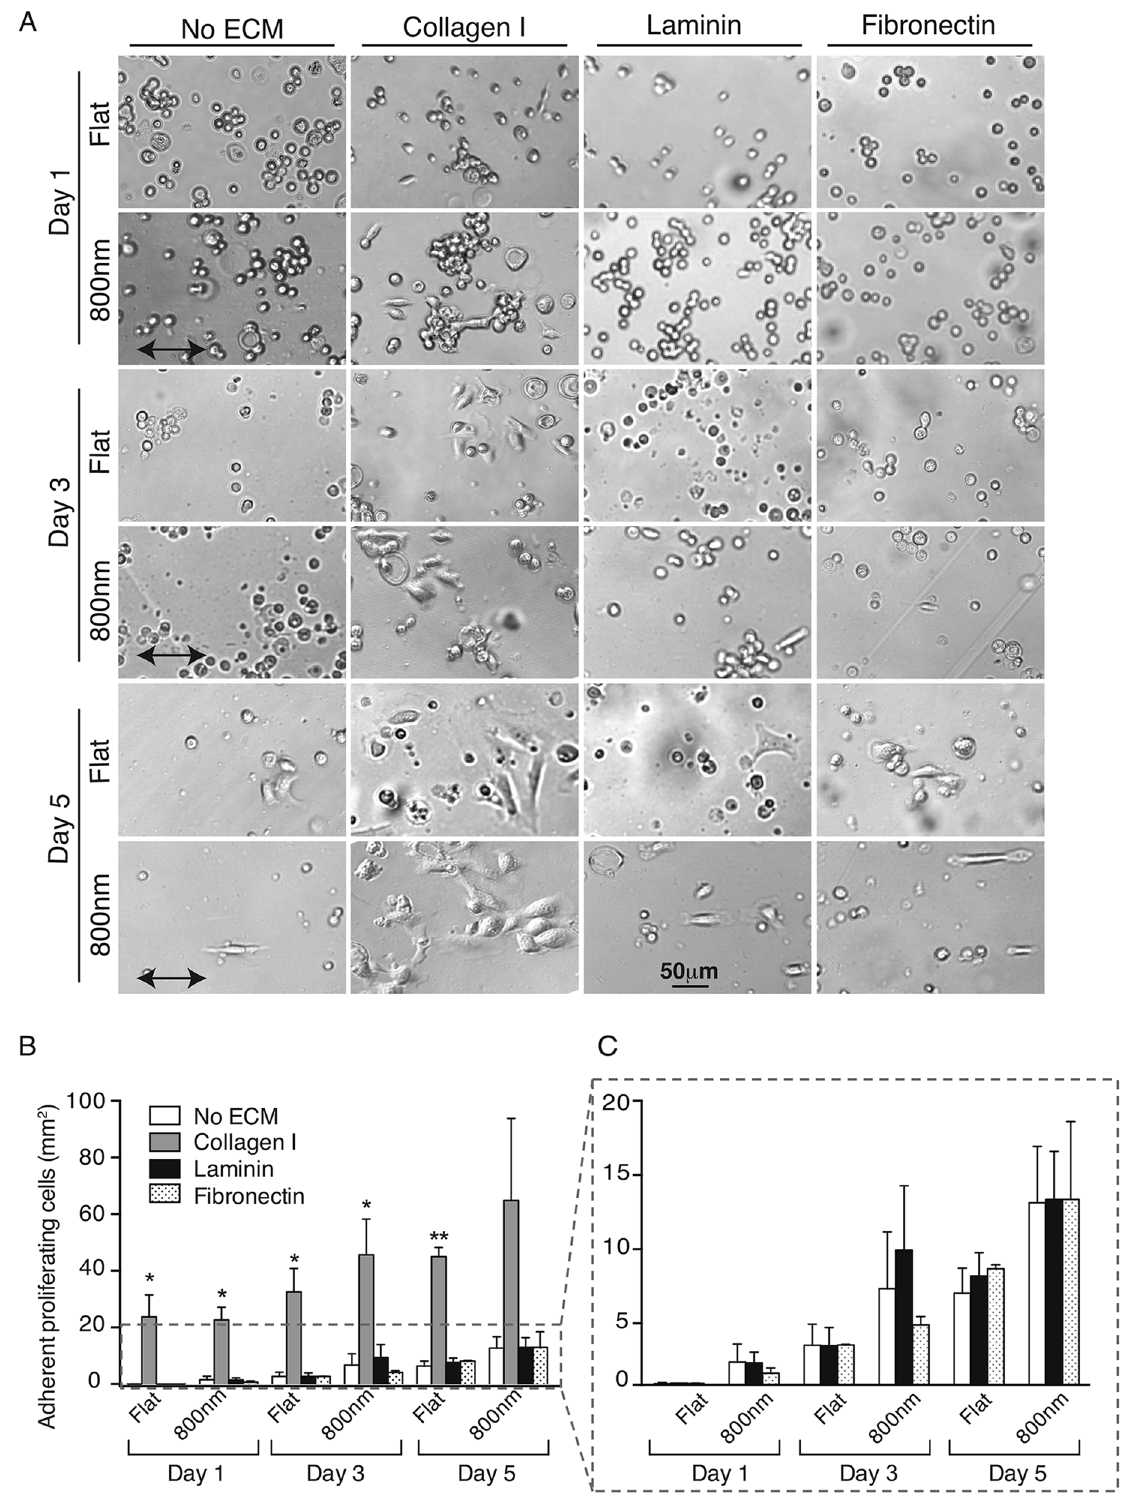
Figure 2. Collagen I coating of silk films enhanced cellular spreading and growth. MCEC were seeded on uncoated or collagen I, laminin, fibronectin or Poly-d-Lysine coated flat or 800 nm patterned silk films. ( A ) Representative phase-contrast images showing cellular shape and spreading. Higher cell number was observed on collagen I coated films through the days of analysis and the cell morphology and attachment was strikingly different to the effects of other ECMs. ( B ) Quantification of cell number showed that fivefold more spreading cells were present on collagen I coated silk in comparison to other ECMs. However, not significant differences were found between collagen coated nanotopographies and flat silk. ( C ) Detailed analysis of other ECMs, showed higher cell number on 800 nm patterned silk coated with laminin and fibronectin at 3-day time point when compared to uncoated flat silk or Poly-d- Lysine coating (data not shown). (* indicates p < 0.05, ** indicates p < 0.005 when comparing between ECMs. Values are means ± S.E.M. The arrow indicates the direction of pattern